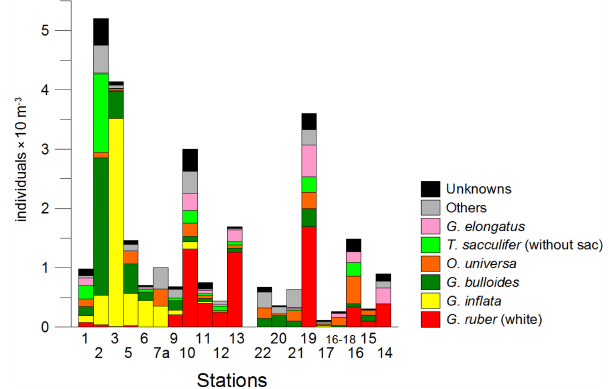
Figure 4. Absolute abundance of planktic foraminifera from BONGO nets during leg 1 (stations 1 to 13) and leg 2 (stations 22 to 14). Category “Others” is comprised of G. siphonifera–G. calida– G. radians plexus, T. quadrilobatus , H. pelagica , G. ruber (pink), G. menardii , and T. sacculifer (with sac).